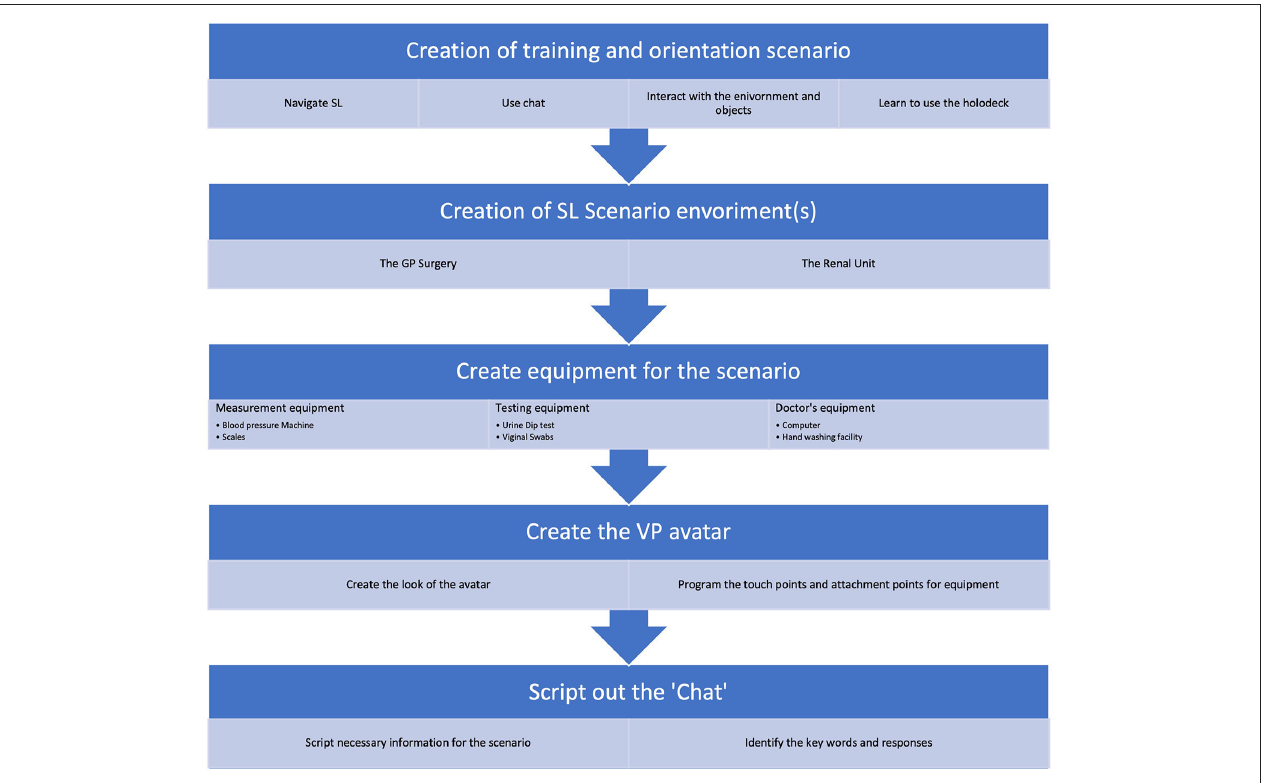
FIGURE 7 | A simple flow of the order in which the elements of the scenario were developed.